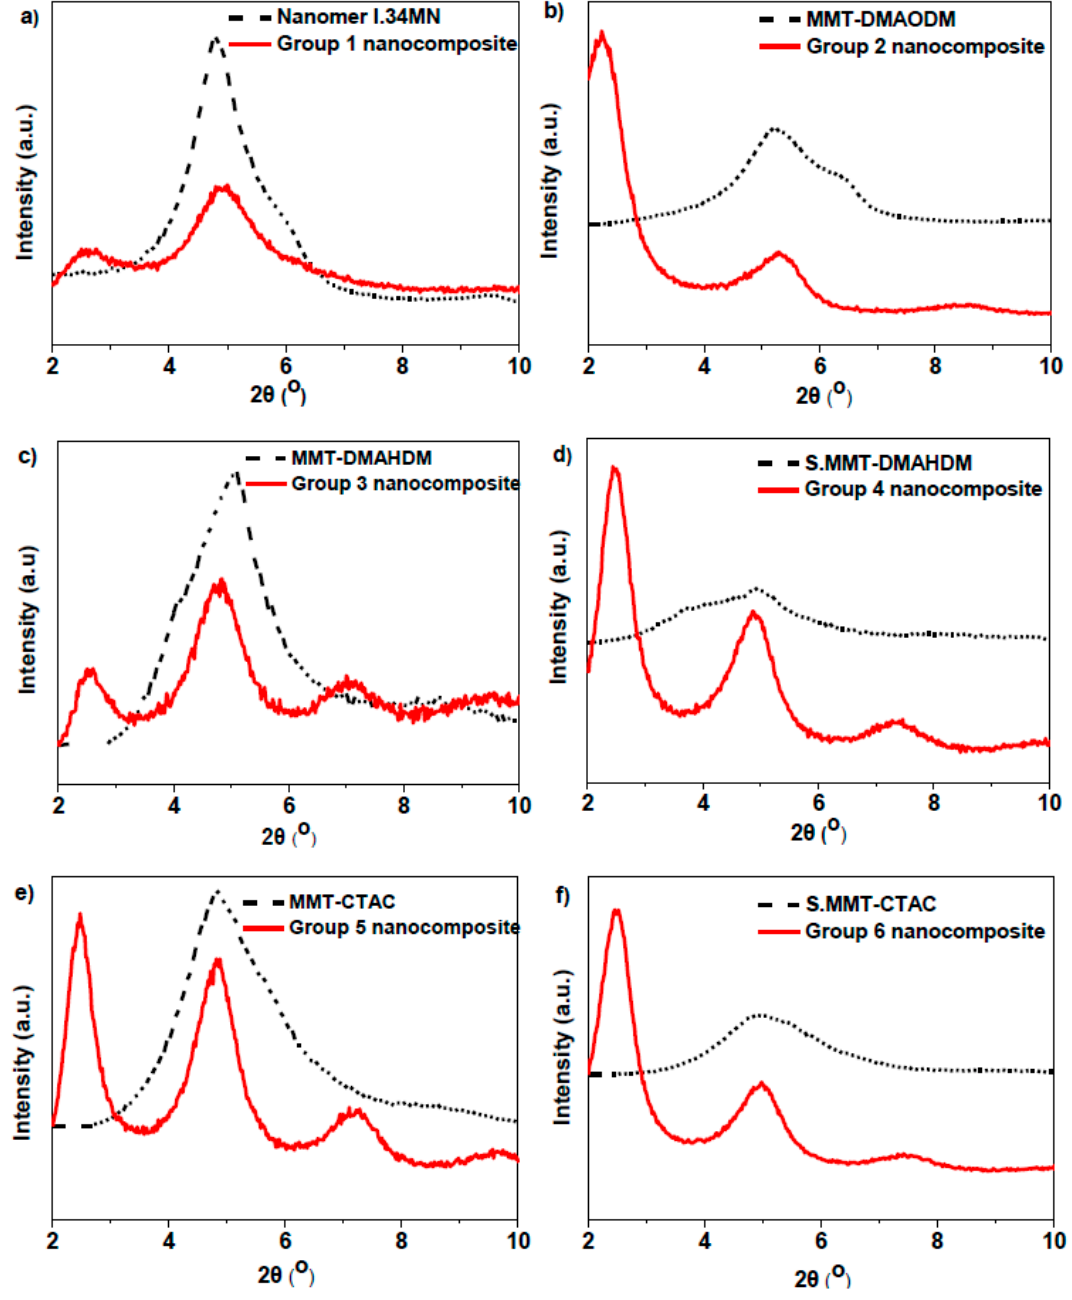
Figure 2. X-ray di ff raction (XRD) patterns of the dental nanocomposite resins and the di ff erent Figure 2. X-ray diffraction (XRD) patterns of the dental nanocomposite resins and the different incorporated organo modified montmorillonite (OMMT) incorporatedorganomodified montmorillonite(OMMT)nanoclays.